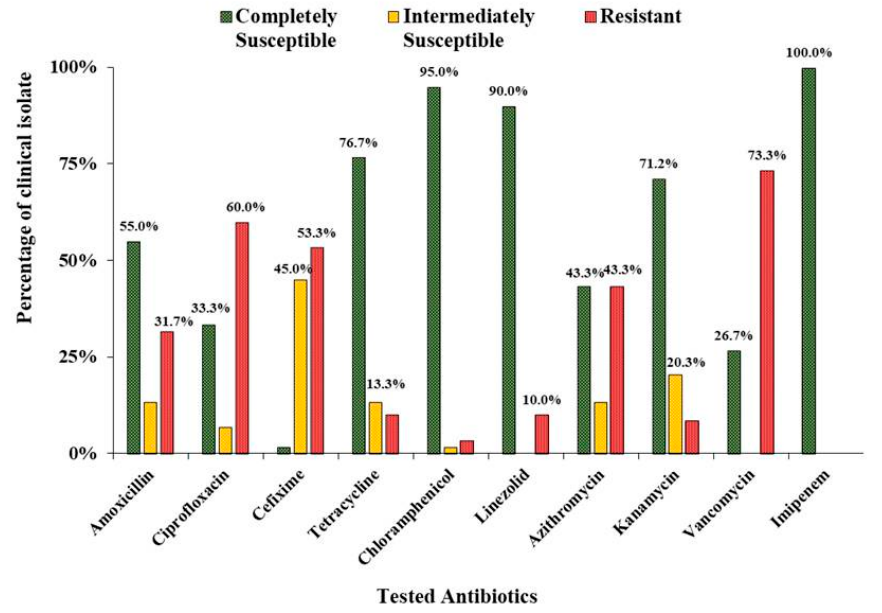
Figure 1. Antibacterial susceptibility profile of the clinical isolates of S. aureus . Table 2. Characterization of different types of S. aureus in the clinical isolates ( n = 60).